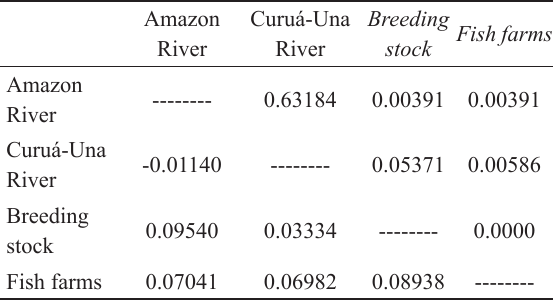
Matrix of pairwise Fst values (bellow the diagonal) as well as Probabilities (above the diagonal) for the comparison between the four study populations of C. macropomum